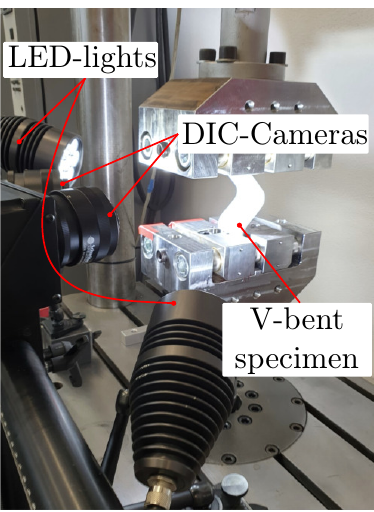
Figure 3. Test setup for force-controlled LCF tests on V-bent structural components using 3D digital image correlation for strain